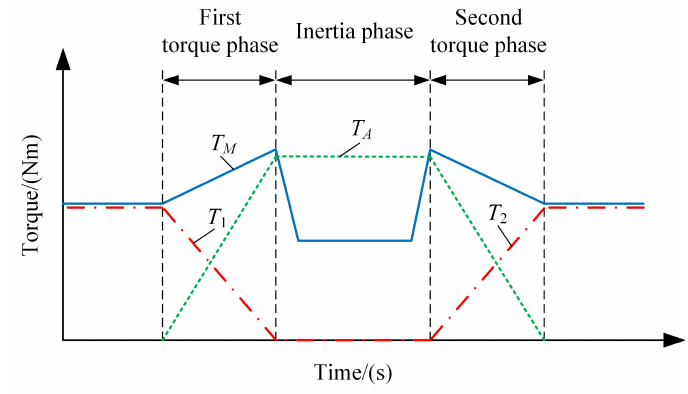
Figure 2. Schematic diagram from first gear to second